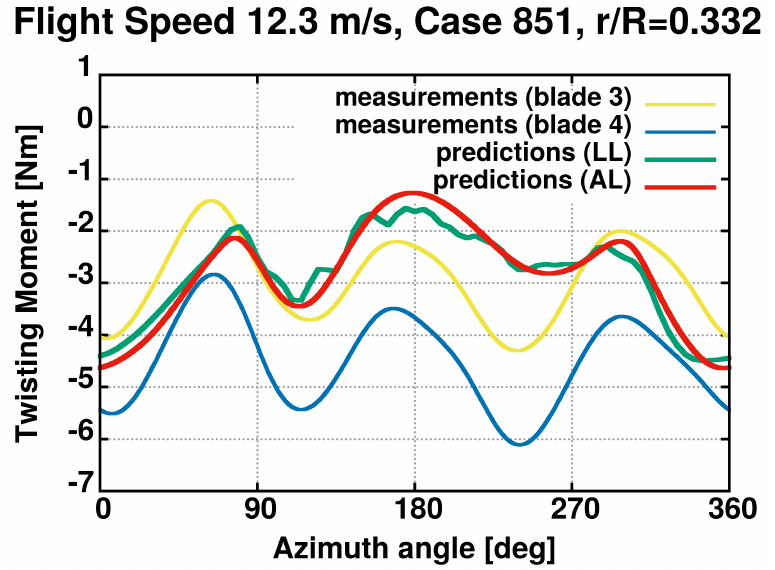
Figure 40. Forward flight at 12.3 m/s, case 851. Twisting moment at r / R = 0.332.